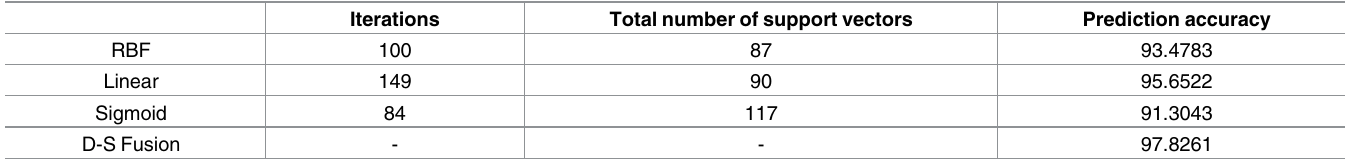
Table 10. Parameters of